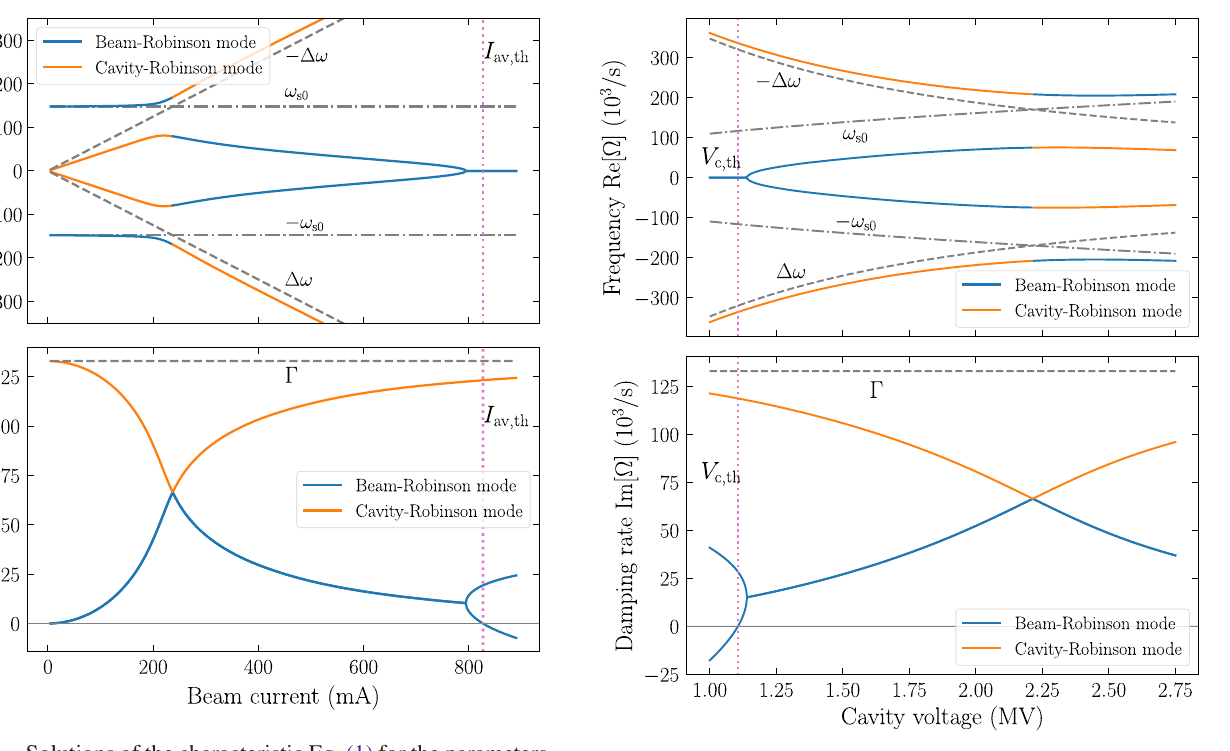
frequency.FIG. 1. Solutions of the characteristic Eq. (1) for the parameters FIG. 2. Solutions of Eq. (1) as functions of the cavity voltage of the PF storage ring given in Table I. Upper and lower graphs with a fixed beam current of 350 mA. The solid lines show the show the real and the imaginary parts of the solutions, respec- solutions, the dashed lines show the cavity detuning frequency or tively, as functions of the beam current when the total cavity the damping rate of the cavity, and the dashed-dotted lines show ¼ 1 . 70 MV. The solid (blue and orange) voltage is fixed at V c the incoherent synchrotron lines show the solutions, and gray dashed lines indicate the detuning frequency ( Δ ω ) of the cavity under optimum tuning or the damping rate ( Γ ) of the cavity. The dashed-dotted lines show the incoherent synchrotron frequency ( ω s 0